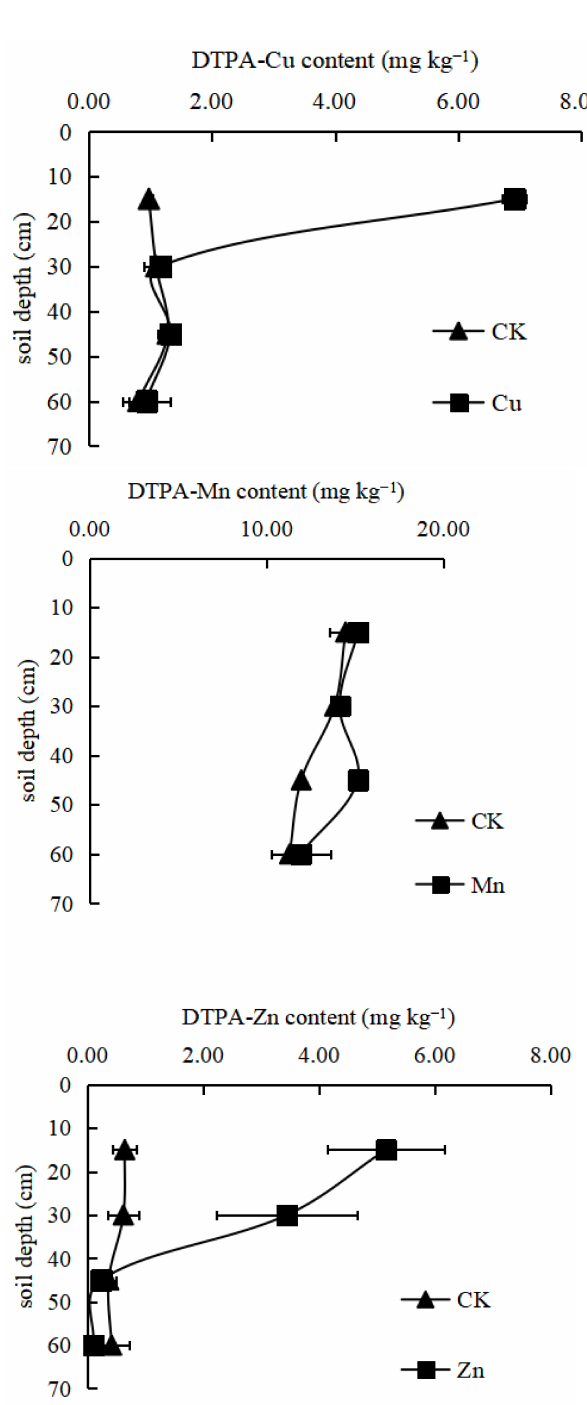
Figure 1. Effects of the long-term application of micronutrient fertilizers on micronutrient availability. Values are means with standard deviations shown by the vertical bars (n =